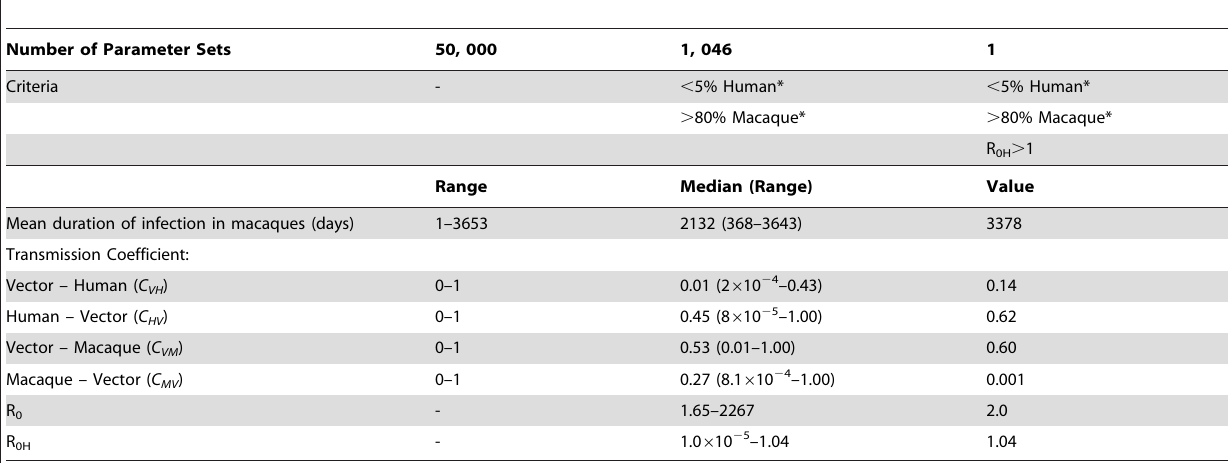
Table 2. The median value and ranges of parameter values for P. knowlesi transmission probability and the macaque infectious period that satisfy the criteria at each model validation step.